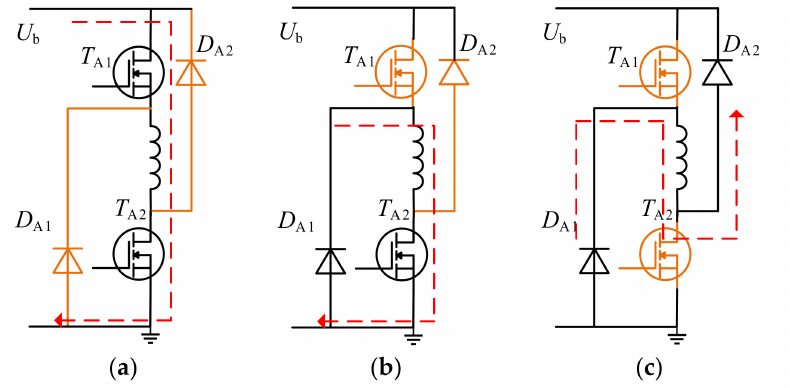
Figure 5. The three switching states. ( a ) State “1”, ( b ) state “0”, and ( c ) state “ − 1”. As shown, states “1”, “0”, and “ − 1” indicate that both the switches are on, only one